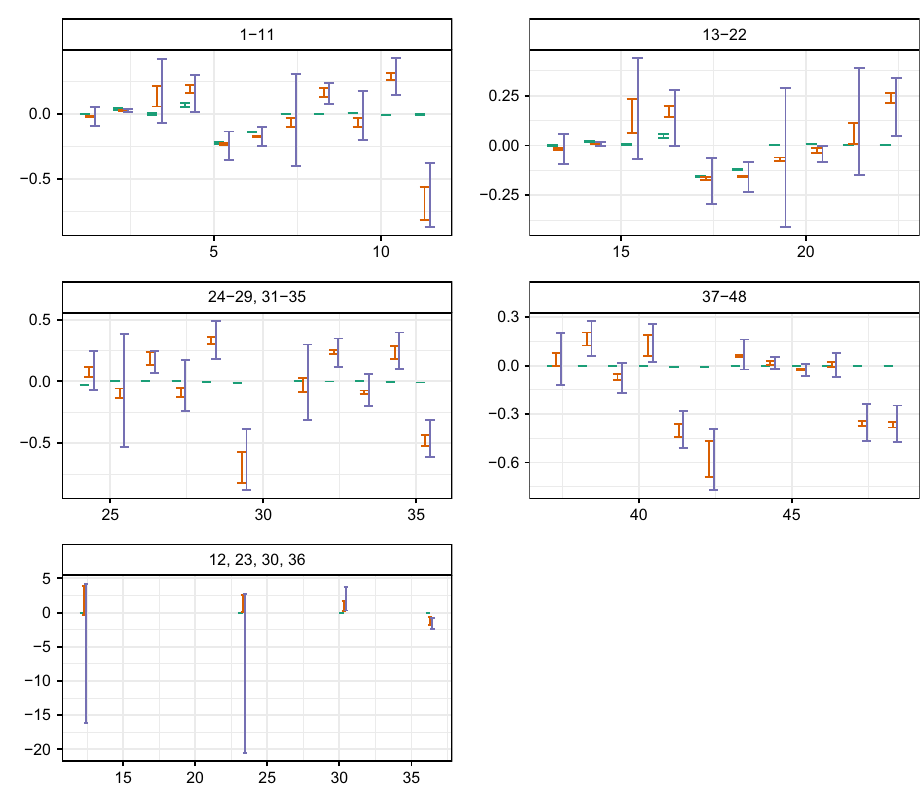
Fig. 10 Comparison of SM prediction (green), BF prediction (brown) and fit uncertainty (purple) for the proposed observables listed in Table